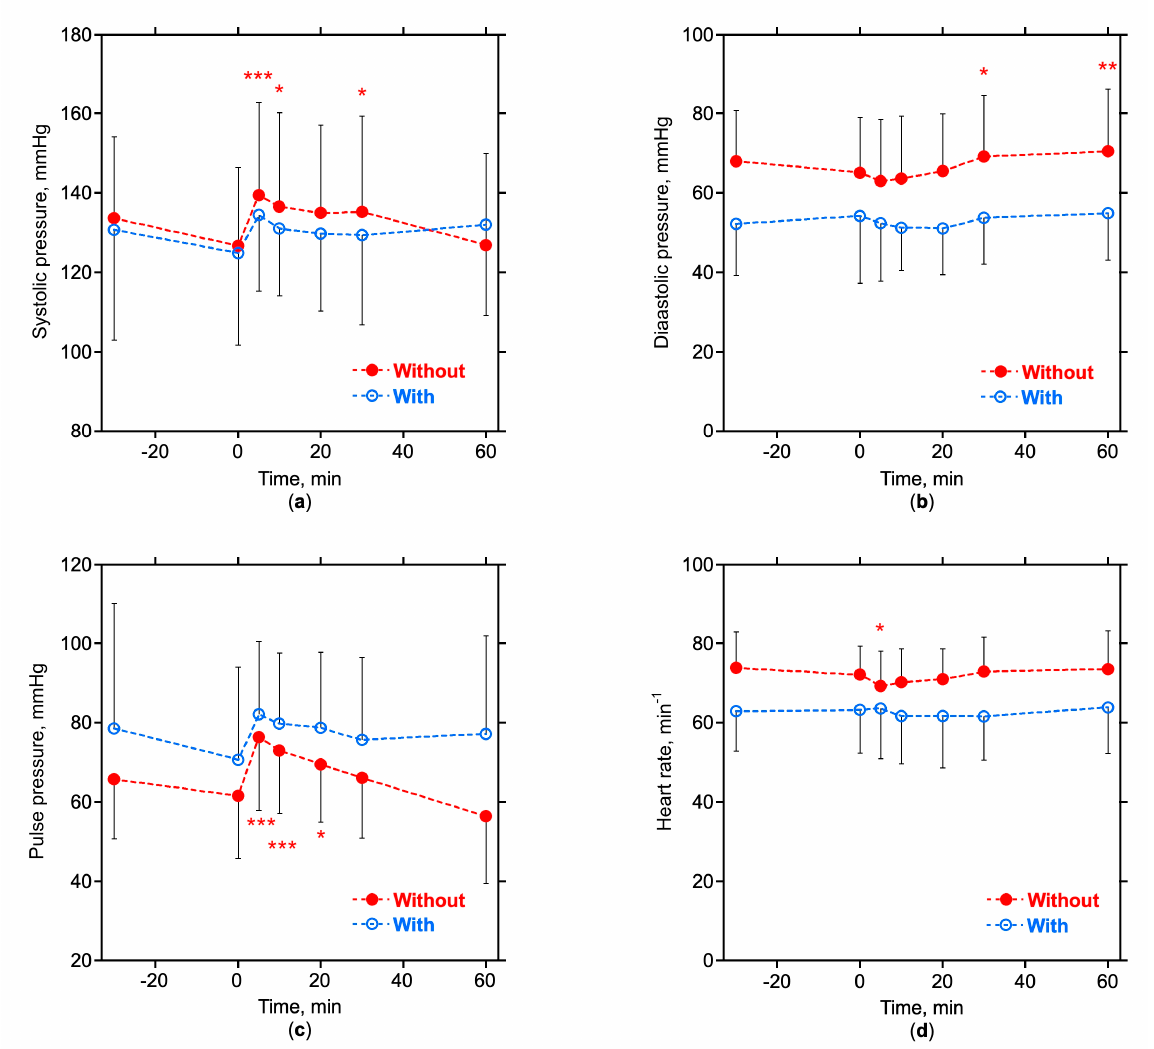
Figure 3. Arterial pressures and heart rates. Average ± SD data in subjects without (closed symbols) and with T2D (open symbols). Glucose is injected at time t = 0. Broken lines indicate interpolations between measuring points; ( a ) systolic pressures; ( b ) diastolic pressures; ( c ) pulse pressures; ( d ) and heart rates; *, p < 0.05; **, p < 0.01, and ***, p < 0.001 different from value at t = 0 (ANOVA for repeated measurements and Dunnett’s post-hoc test).